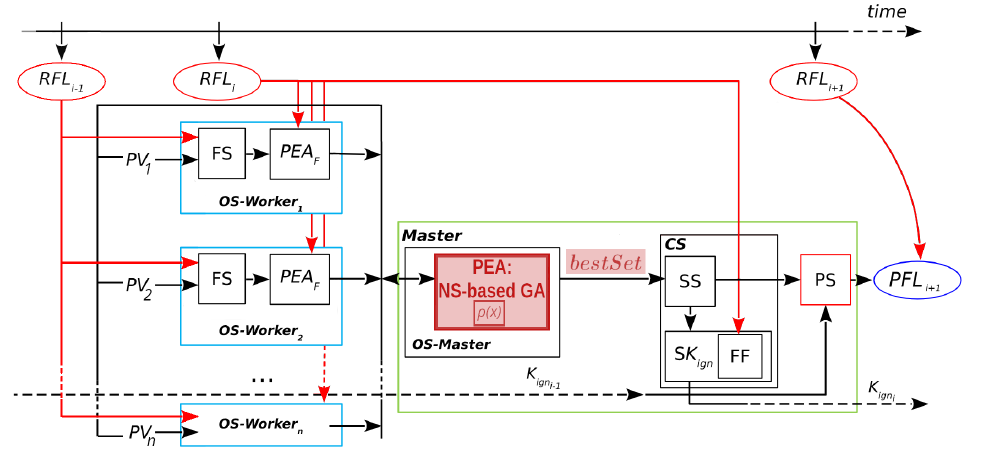
Figure 5. Evolutionary Statistical System based on Novelty Search. RFL i : real fire line of instant t i ;